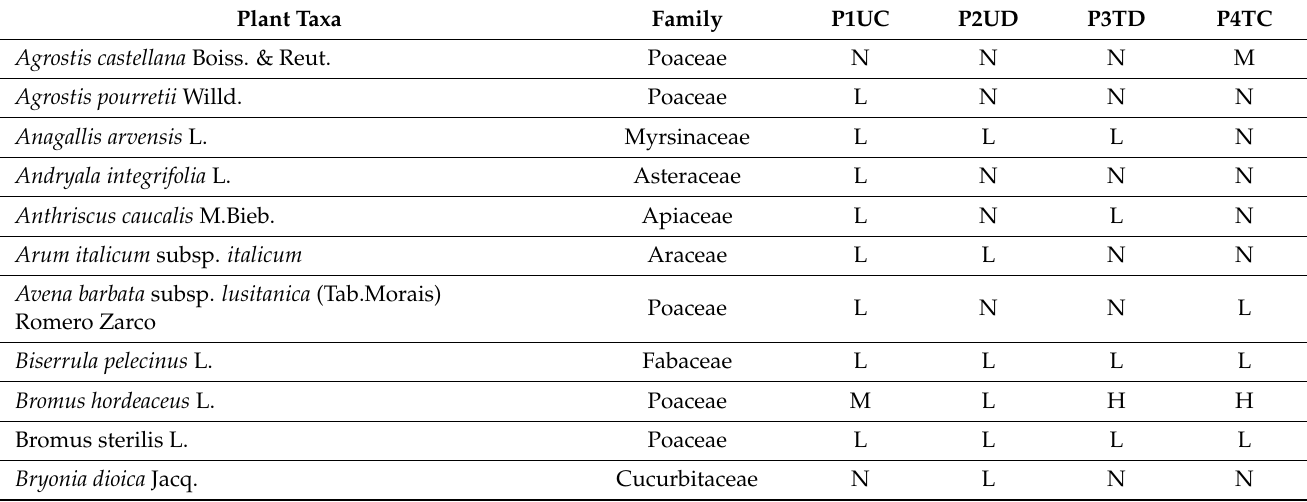
Table A2. Plant species identified in each plot, in